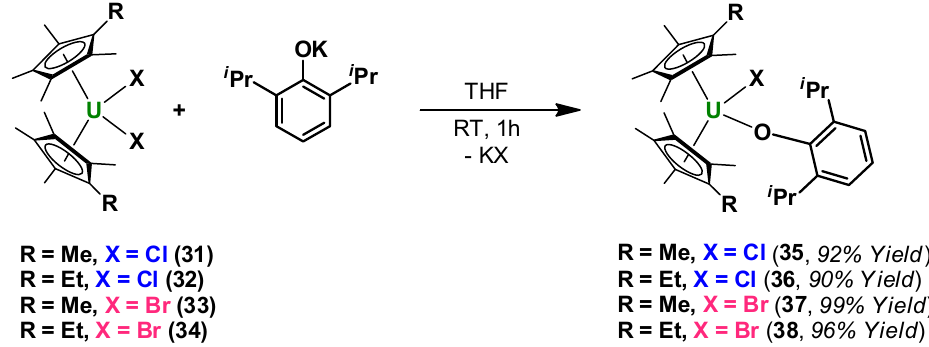
Scheme 2. Synthesis of the halide aryloxide mixed-ligand uranium(IV) complexes (C 5 Me 4 R) 2 U( O -2,6- i Pr 2 C 6 H 3 )(Cl) (R = Me ( 35 ), Et ( 36 )) and (C 5 Me 4 R) 2 U( O -2,6- i Pr 2 C 6 H 3 )(Br) (R = Me ( 37 ), Et ( 38 )) by salt metathesis.